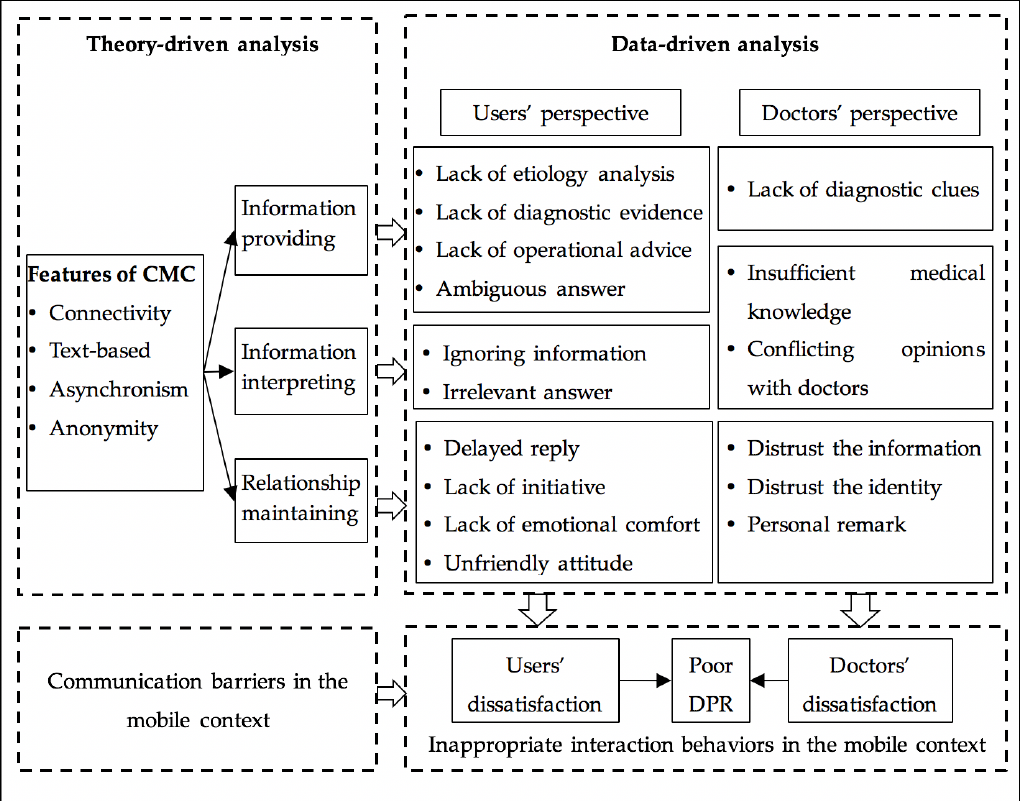
Figure 3. Antecedents of poor DPR in the mobile medical context.